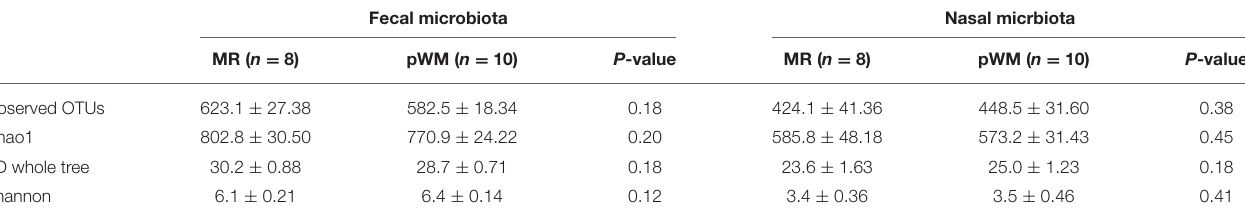
TABLE 2 | Alpha-diversity indices ( ± SE) for both fecal and nasal microbiota communities from calves fed either milk replacer (MR) or pasteurized waste milk